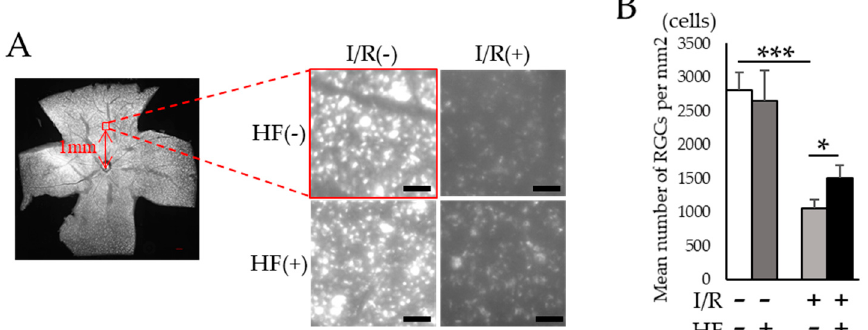
Figure 5. Fluorogold retrograde labeling of retinal ganglion cells (RGCs). ( A ) A representative quadrant retinal image with fluorogold-labeled RGCs. Red 200 µ m square at 1 mm from optic disc head indicates the area for RGC densitometry (left). Magnified images for control and post-I / R retina with or without halofuginone treatment (right). Scale bars; 200 µ m in quadrant retina, 50 µ m in magnified images. ( B ) The quantification of RGC density for each group ( n = 3). Note that decrease of RGCs was suppressed by topotecan administration. HF; halofuginone. Error bars indicate the standard deviation. * p < 0.05, *** p < 0.001, Student’s t -test.